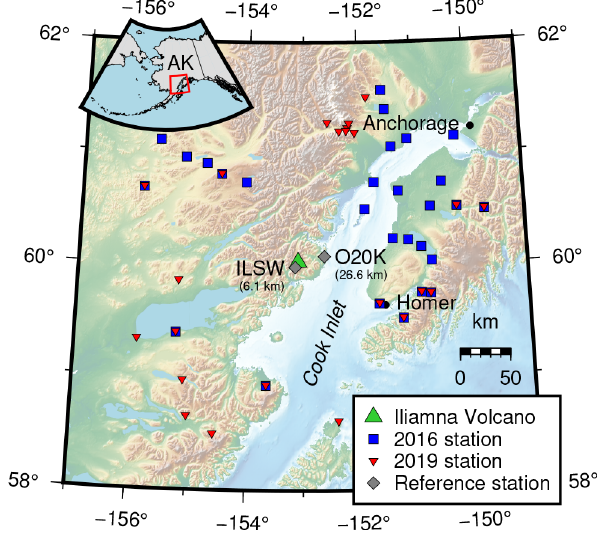
Figure 1. Map of the Cook Inlet region, Alaska. Iliamna Volcano is indicated by the green triangle. Broadband seismic stations used in the 2016 (28 stations) and 2019 (23 stations) force inversions are shown as blue squares and red inverted triangles, respectively. Overlapping markers denote stations used in both inversions. The station distribution varies greatly between the two events due to the presence of a temporary seismic array in 2016 and increased Transportable Array station coverage in 2019. Reference stations ILSW and O20K (the closest seismometer and infrasound sensor to the events, respectively) are shown as gray diamonds with their distances to Iliamna Volcano given in parentheses. The city of An- chorage and the town of Homer are marked as black dots. The red box in the inset shows the main map